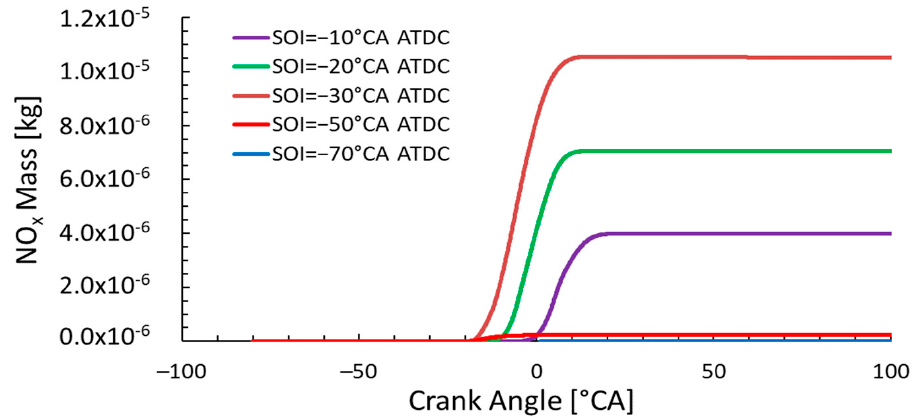
Figure 12. Effect of SOI timing on the in-cylinder NO x formation history.